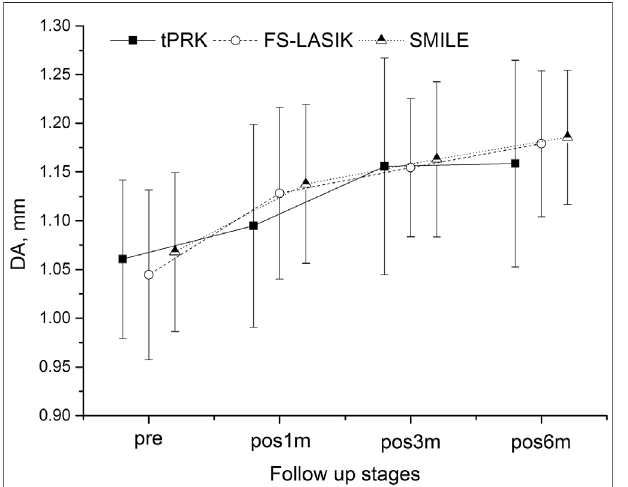
FIGURE 4 | Changes in the deformation amplitude 2 mm away from apex and the apical deformation (DARatio2mm) throughout all follow-up stagesinthetPRK,FS-LASIK,andSMILEpatientgroups(meanandstandard